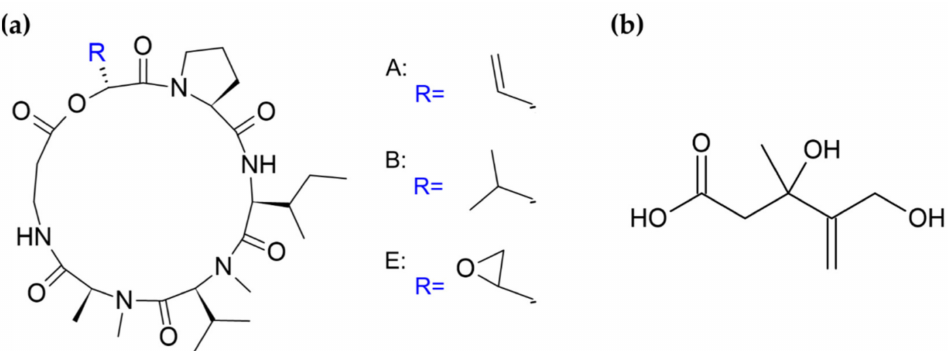
Figure 4. Exuded compounds and agriculture. The structure of: ( a ) destruxins (A, B, E) [70]; ( b ) mevalocidin